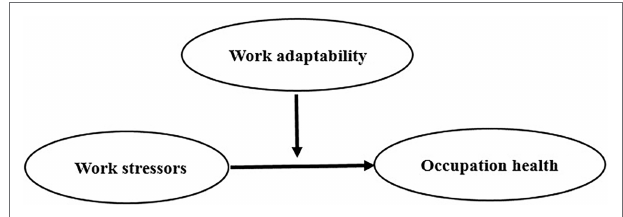
FIGURE 1 | Hypothesized research